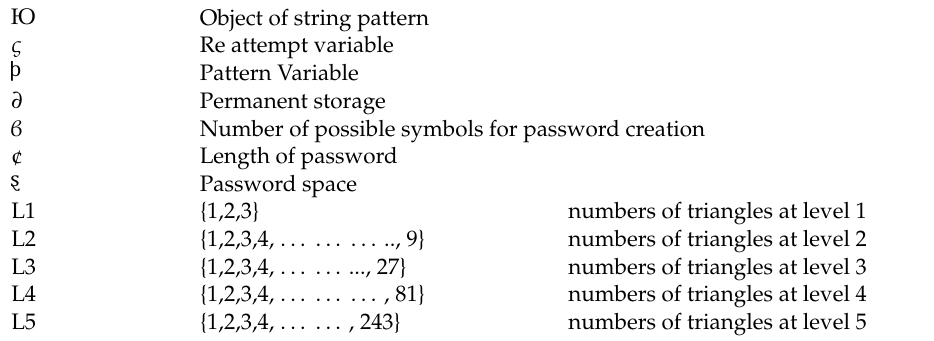
Figure 3 . Sequence diagram for password registration and verification. Table 2 . Notations.